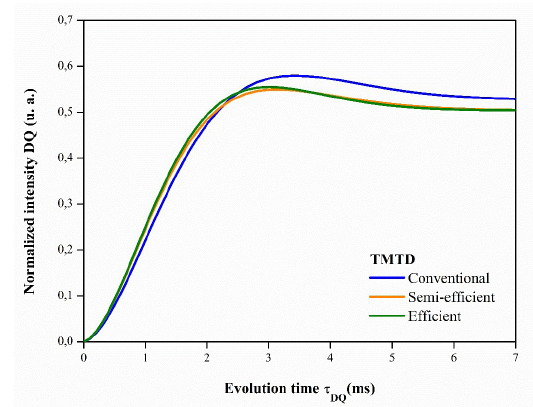
Figure 3. Delta tangent curves (Tan δ) of NR compounds vulcanized and accelerated by: MBTS, TMTD and CBS in their respective crosslinking systems.